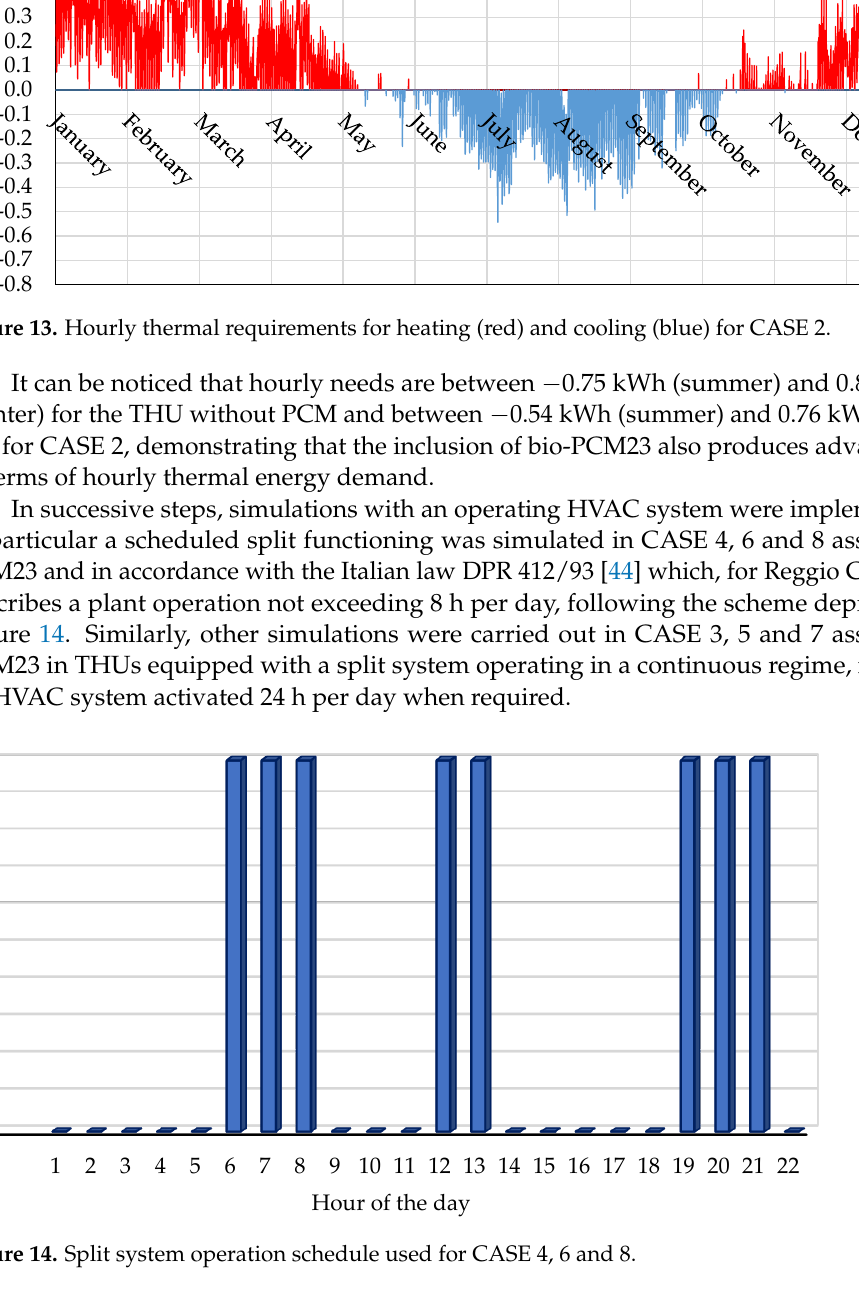
Figure 12. Hourly thermal requirements for heating (red) and cooling (blue) for CASE 1.